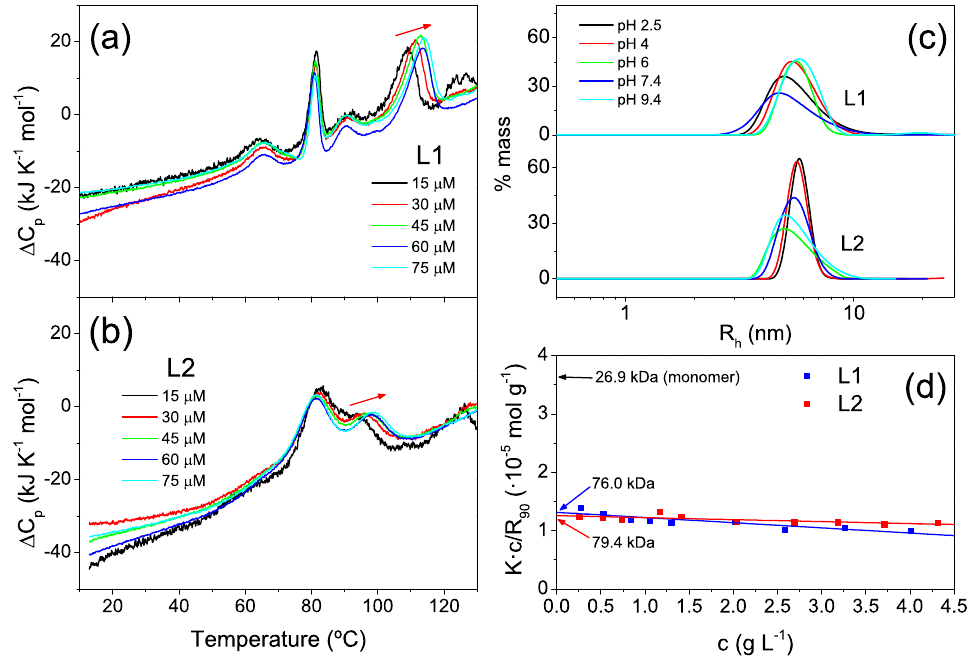
Figure 4. Effect of protein concentration on stability and molecular size characterization. ( a , b ) DSC thermograms measured for L1 ( a ) and L2 ( b ) proteins at pH 7.4 and varying protein concentrations between 15 and 75 µ M. The red arrows highlight temperature shifts of the unfolding transitions associated with increased concentration, suggesting oligomer dissociation accompanying unfolding. ( c ) Distributions of hydrodynamic radii measured by DLS for L1 and L2 proteins at varying pH values and 25 °C. ( d ) Debye plots obtained by scattering intensity measurements with protein samples of varying concentrations at pH 7.4 and 25 °C according to Equation (1) (see Section 4). The intercepts of the linear regressions correspond to the inverse of the weight-averaged molecular weights (1/ M w ) of the particles in solution. The theoretical intercept (1/ M w ) for the protein monomers is also